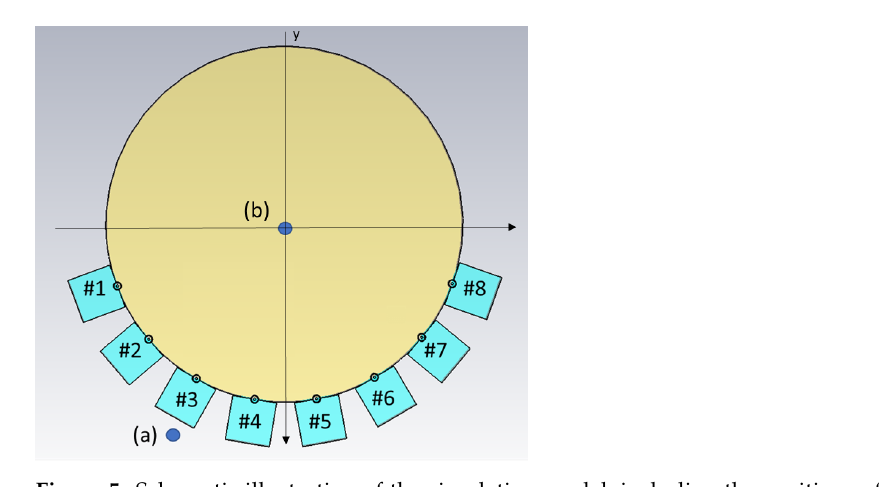
Figure 5. Schematic illustration of the simulation model, including the positions of the two field probes ( a , b ). Antennae are numbered #1–#8.